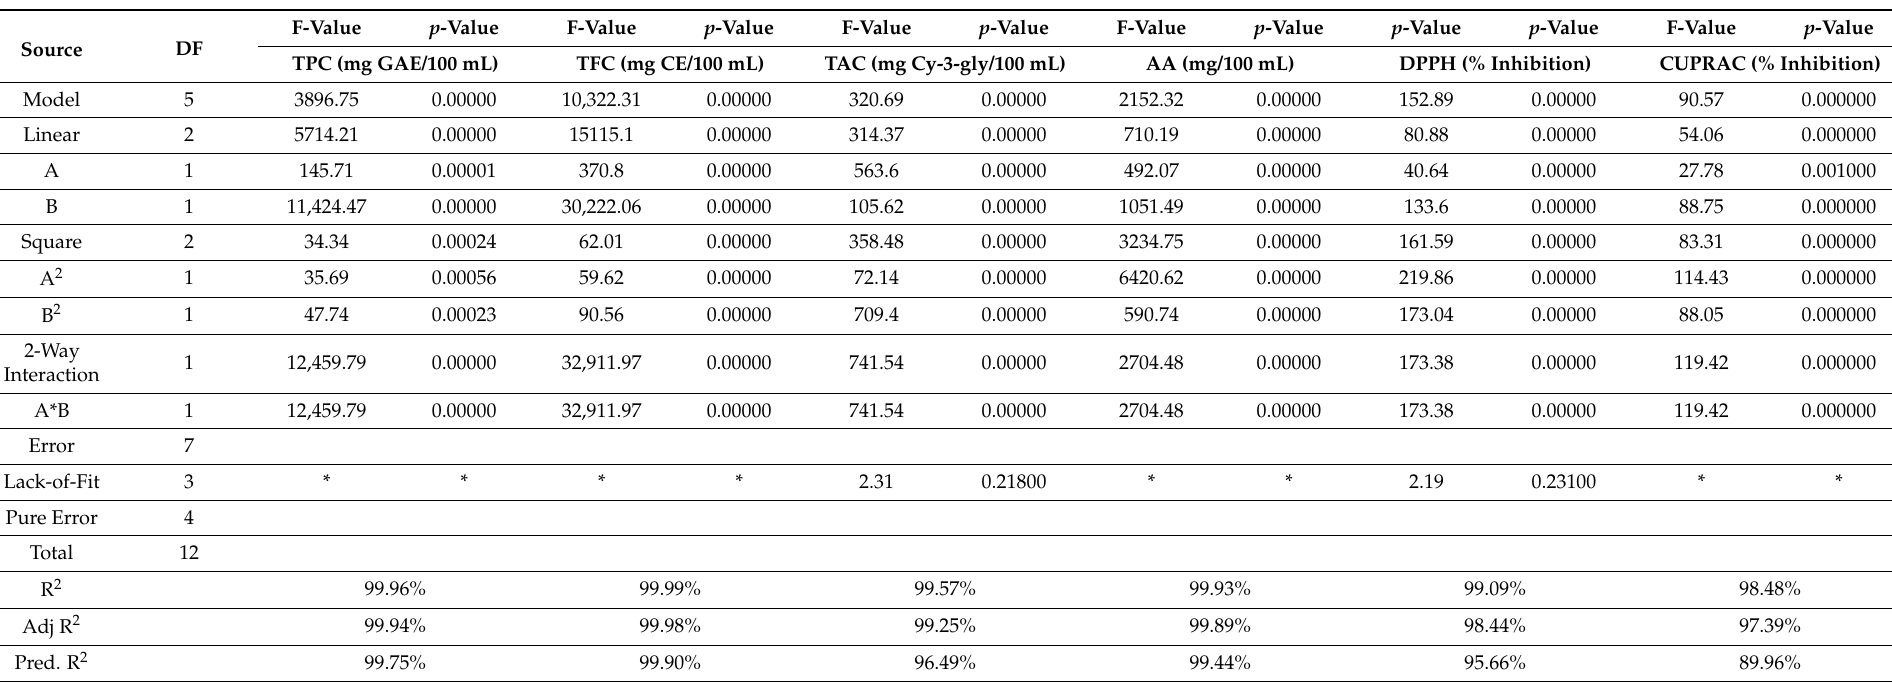
Table 3. Corresponding p -values of linear, interaction, and quadratic terms of regression coefficients obtained by RSM of responses for TPC, TFC, TAC, AA, DPPH, and CUPRAC